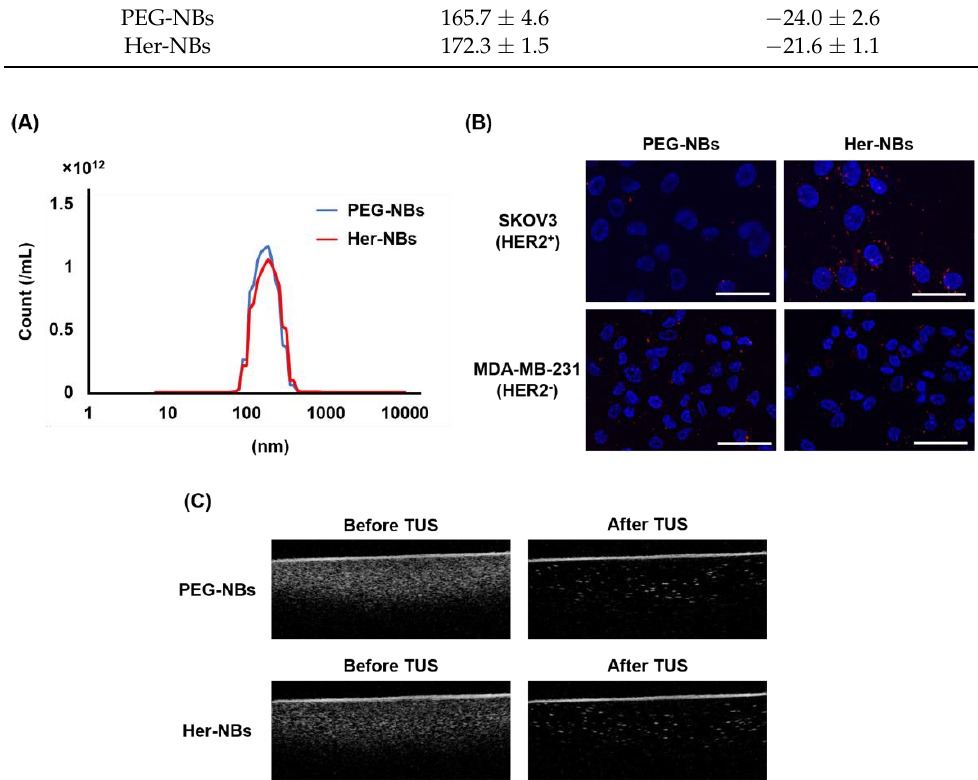
Figure 2. Characterization of non-modified PEG-NBs and Her-NBs. ( A ) Particle size distribution was measured via Laser Diffraction Method. ( B ) Attachment of Her-NBs and cancer cells. DiI-labeled NBs were incubated with SKOV3 (HER2 + cancer) cells or MDA-MB-231 (HER2 − cancer) cells for 5 min, and then DAPI was added to the cells to stain nuclei. Red: DiI-labeled NBs, Blue: DAPI, scale bar: 50 µ m. ( C ) Ultrasound contrast images of NBs before/after therapeutic ultrasound (TUS) exposure (frequency, 1 MHz; duty, 50%; intensity, 1 W/cm 2 ; time, 2